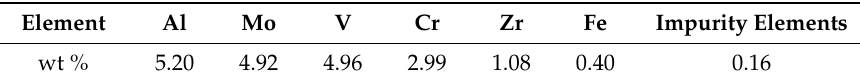
Table 1. Alloy composition of the received